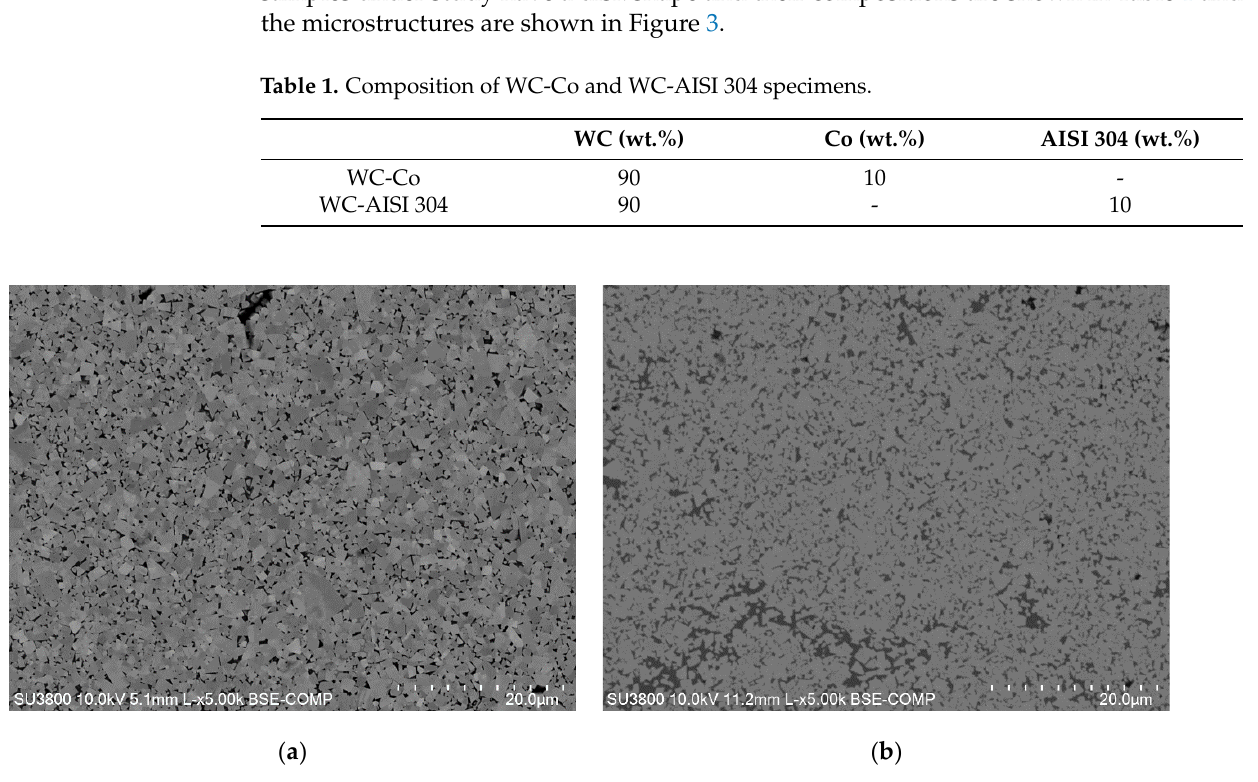
Table 1. Composition of WC-Co and WC-AISI 304